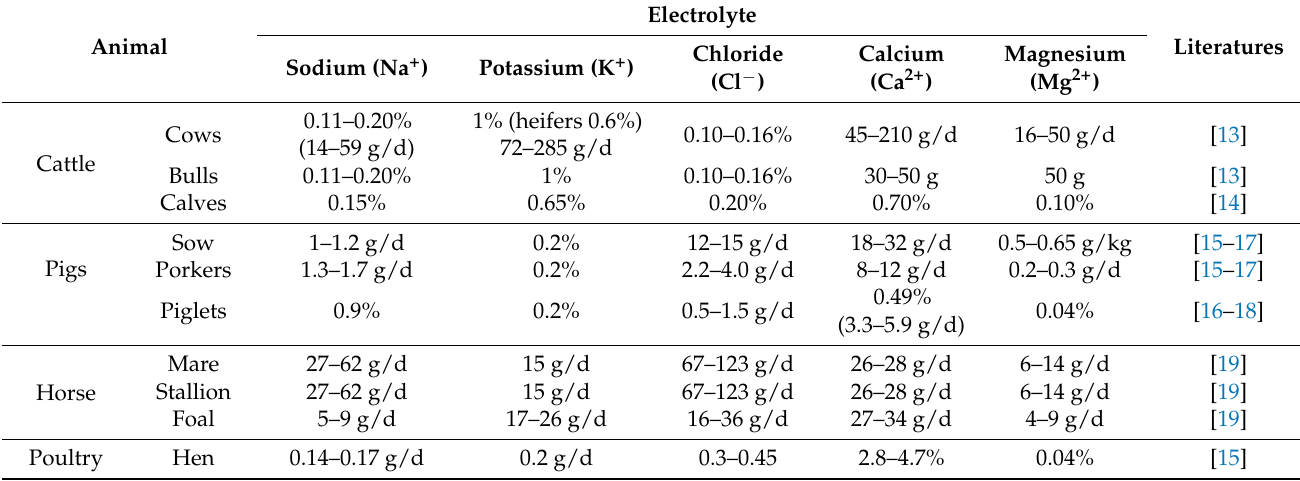
Table 3. Daily demand for electrolytes for selected animal species.